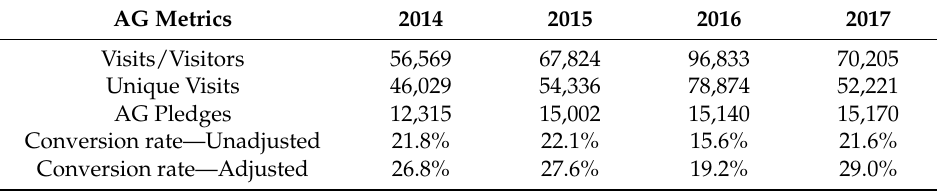
Table 1. Antibiotic Guardian website metrics including conversion rates from